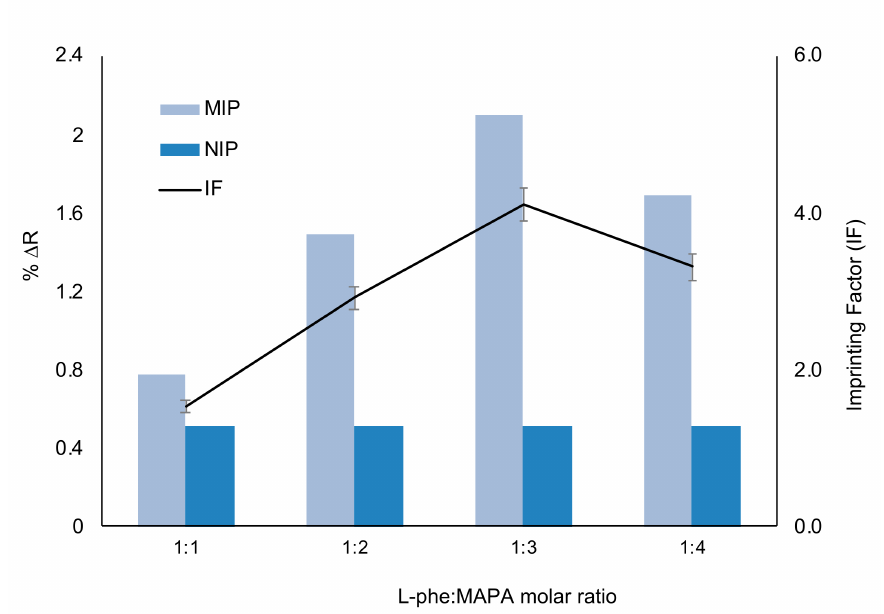
Figure 4. The imprinting factor of L -Phe imprinted and non-imprinted polymeric films.